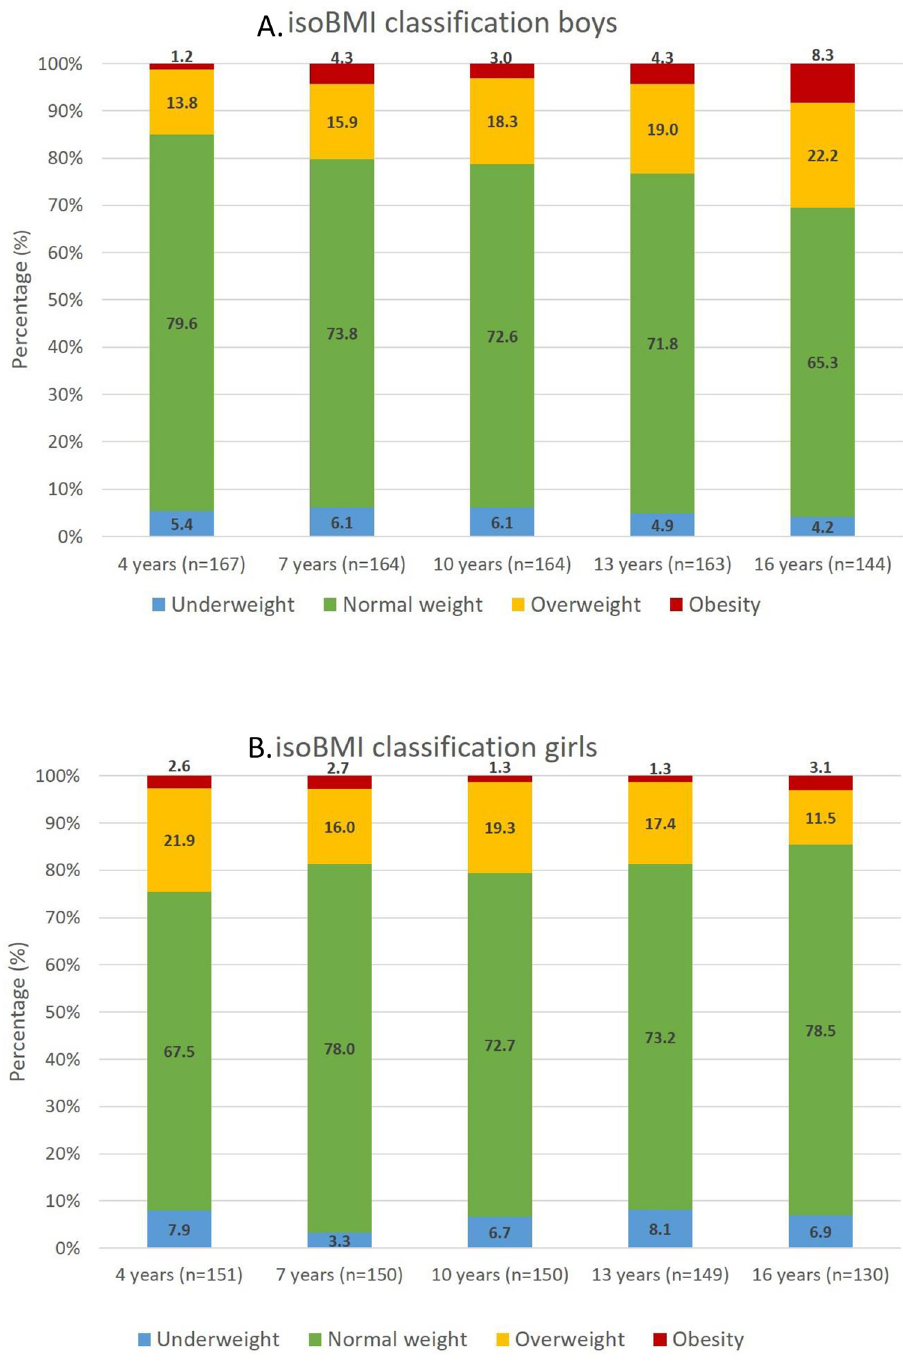
Fig 2. Distribution of body mass index (BMI) classes according to the isoBMI classification in children born 1999– 2000 in the municipality Lidko¨ping at different ages for boys (A) and girls (B) separately.